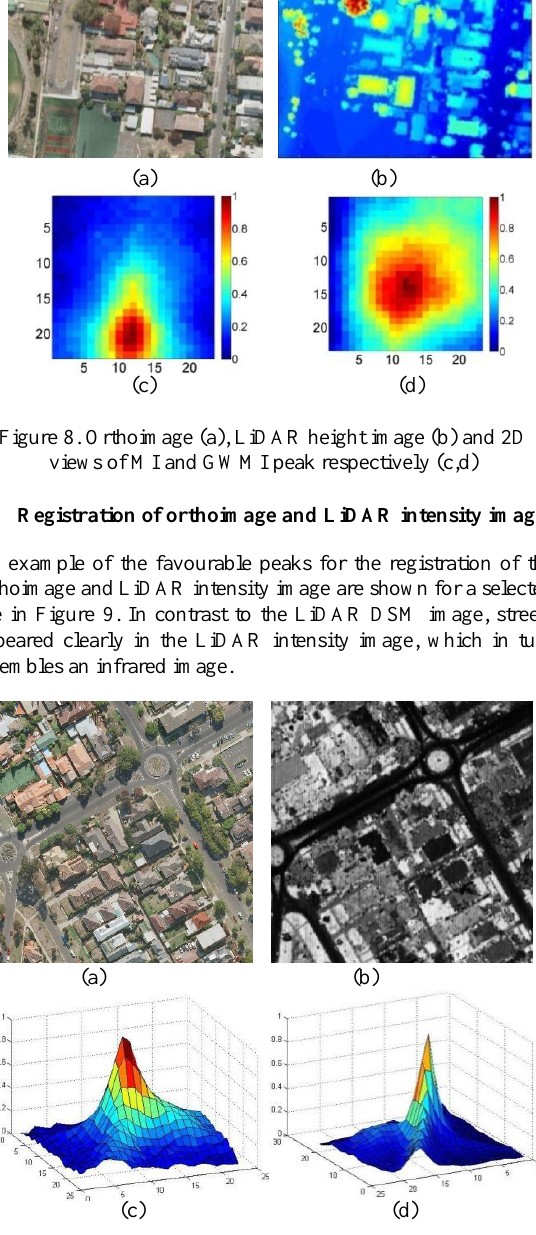
Figure 9. Orthoimage (a), LiDAR intensity image (b), 3D view of MI peak (c) and 3D view of GWMI peak